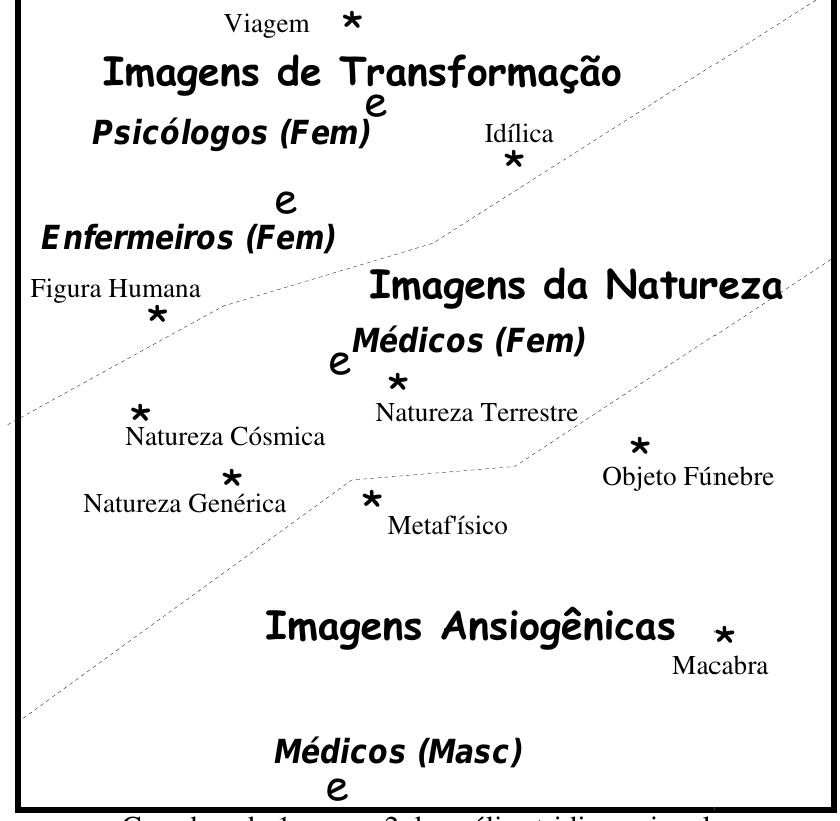
Figura 1. Análise SSA das categorias relativas à Imagens sobre a Morte